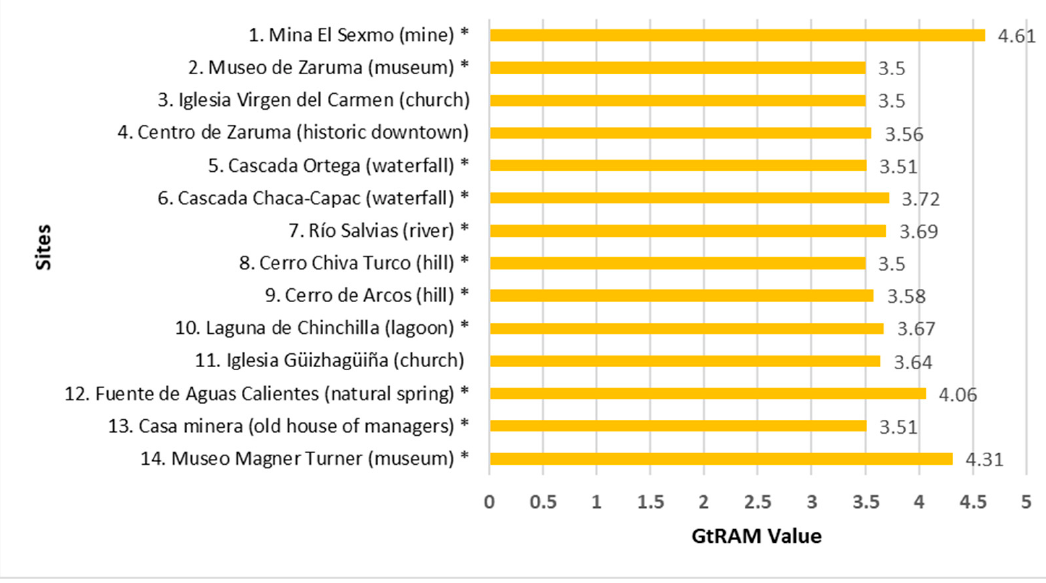
Figure 10. GtRAM evaluation of the sites that make up the new route proposed “La Geodiversidad” in this study. * Geosites/mining sites.